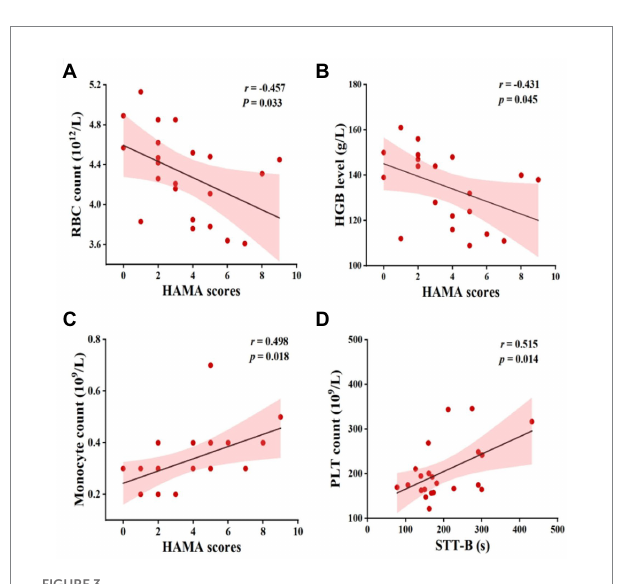
FIGURE 3 Pearson’s correlation between complete blood counts and cognitive function in MCI patients. Abbreviations: RBC, red blood cells; HGB, hemoglobin; HAMA, Hamilton anxiety rating scale; PLT, platelet; STT-B, shape trails test B; MCI, mild cognitive